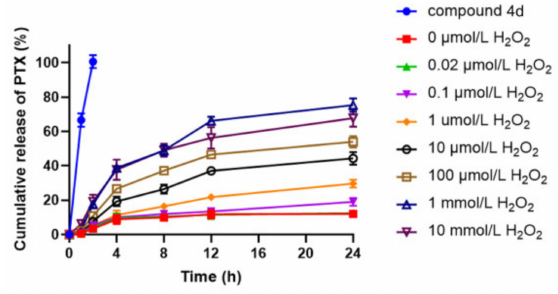
Figure 5. In vitro ROS-sensitive release studies of PTX.